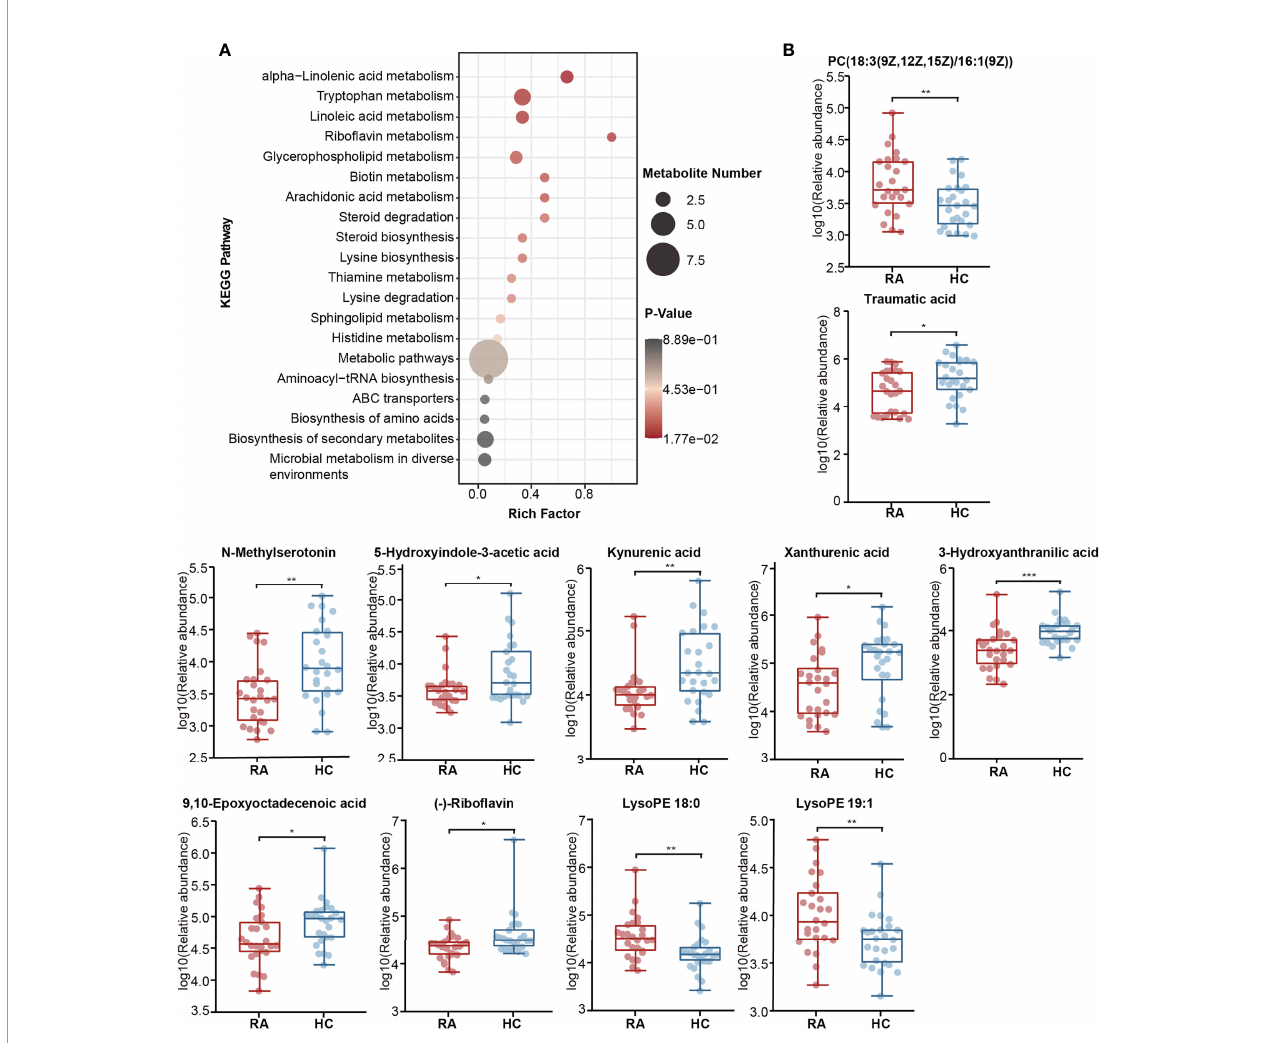
FIGURE 6 | Alterations of KEGG pathway related to RA. (A) The KEGG pathway enrichment scatter plot displayed alterations in the intestinal metabolic processes of RA patients. (B) Eleven differentially abundant metabolites involved in the mainly altered pathways were further illustrated by box maps. P-value, *p < 0.05; **p < 0.01; ***p <